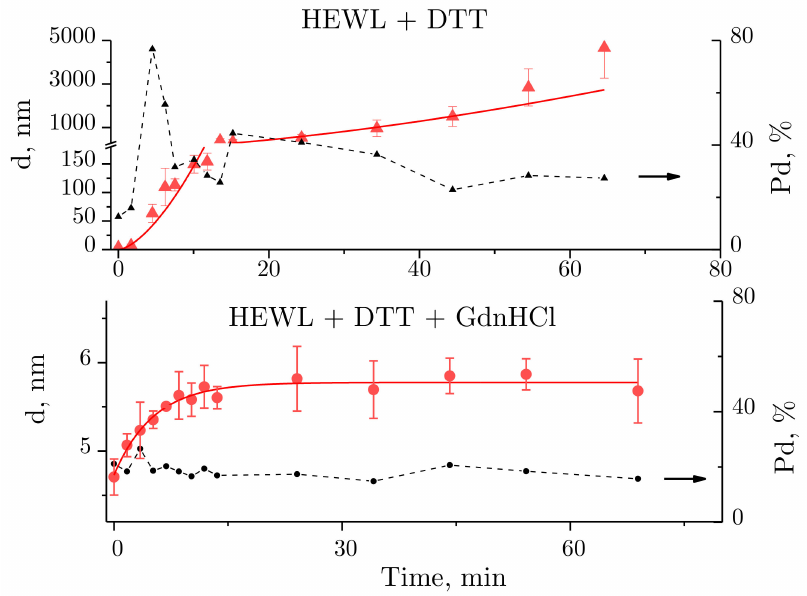
Figure 3. Changes observed over time in the size of molecules and molecular aggregates of lysozyme (red lines) and solution polydispersity (Pd, %) (black dashed line). The data are expressed as means and standard